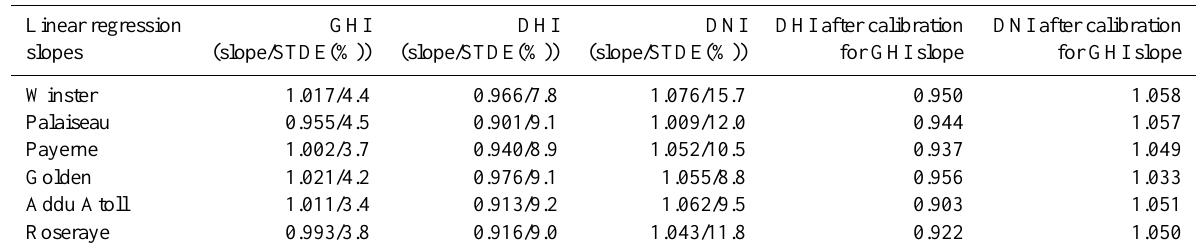
Table 4. GHI, DHI and DNI regression slopes from Fig. 2 comparisons together with DHI and DNI slopes found after calibrating for GHI slope.